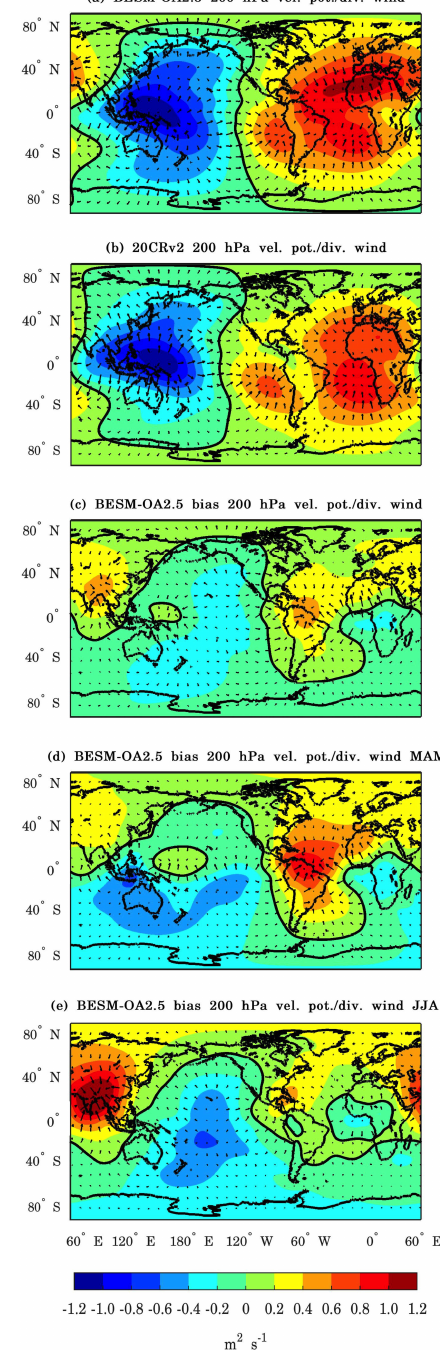
Figure 5. Spatial maps showing the averaged global anomalies in velocity potential and wind divergence at the 200hPa pressure level for (a) BESM-OA2.5 and (b) 20CRv2 reanalysis. (c) The bias of the model relative to the reanalysis; (d) and (e) are the biases for the MAM and JJA seasons, respectively. The averages were computed over the period 1950–2005. Units are in meters per